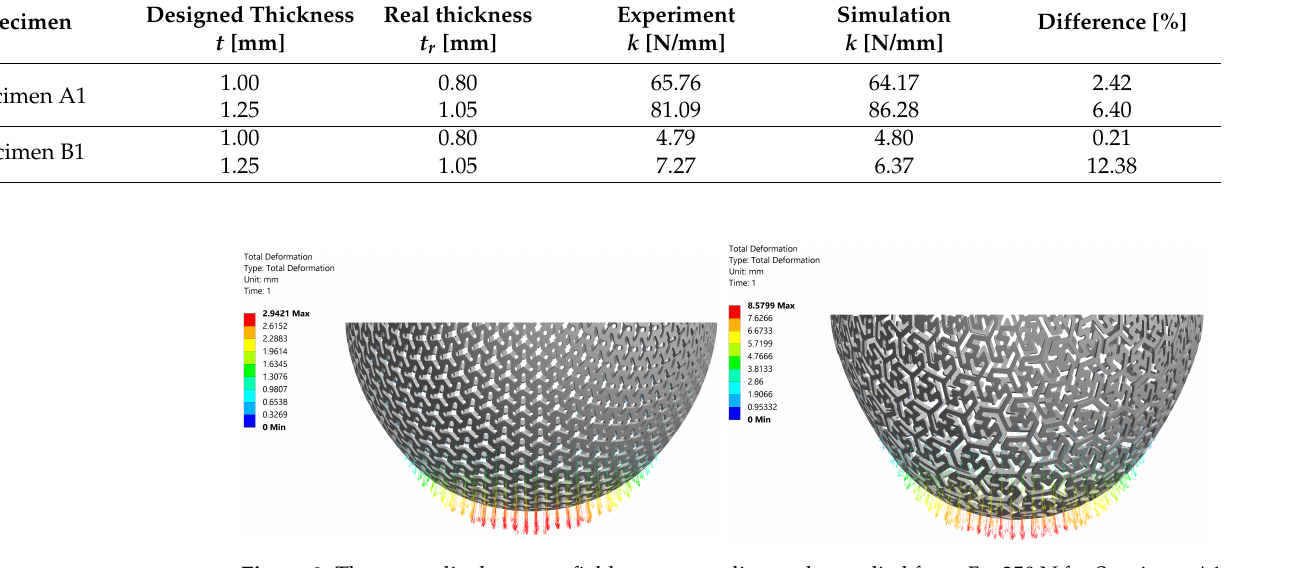
Figure 9. The vectordisplacement fields corresponding to the applied force F = 250 N for Specimen A1 ( left ), respectively the applied force F = 50 N for specimen B1 ( right ), real thickness t r = 1.05 mm.